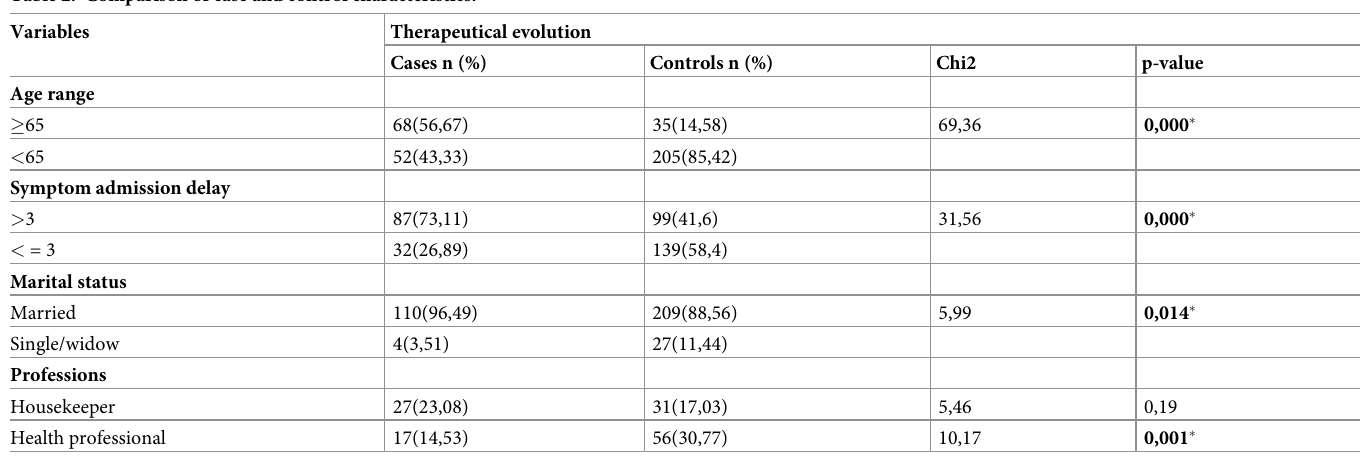
Table 2. Comparison of case and control